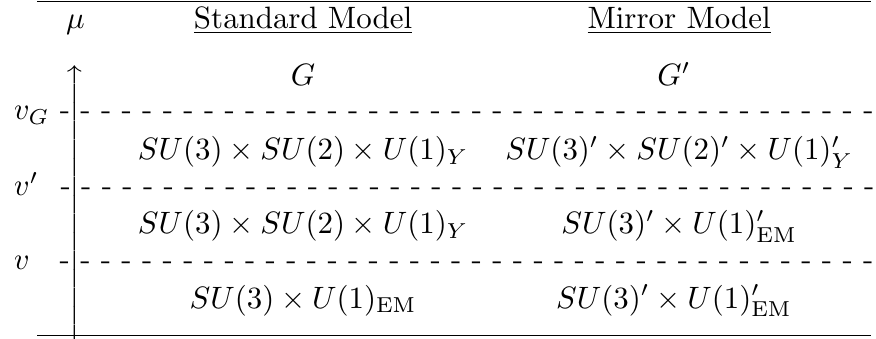
0 , and v G . The gauge groups